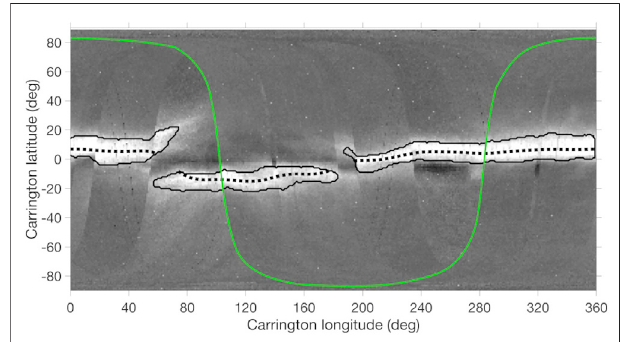
FIGURE 2 | White-light synoptic (or Carrington) map at a height of 5 R ⊙ built after concatenating LASCO C2 images from 2020 – 09 – 19 12:00 to 2020 – 10 – 03 12:00. The green line represents the bands of pixels from the LASCO C2 image shown in Figure 1 that have been projected into the synoptic map. The SB contour and SMB line are drawn as dark solid and dashed lines, respectively (they are introduced in sub section 2.3